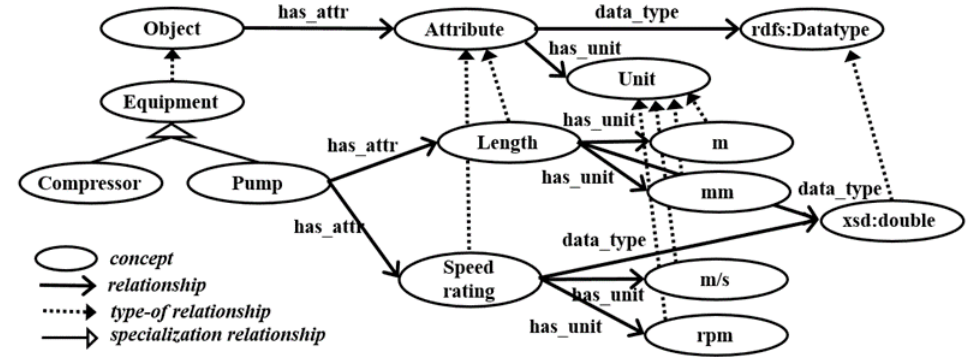
Figure 9. A partial domain ontology example for product specification.